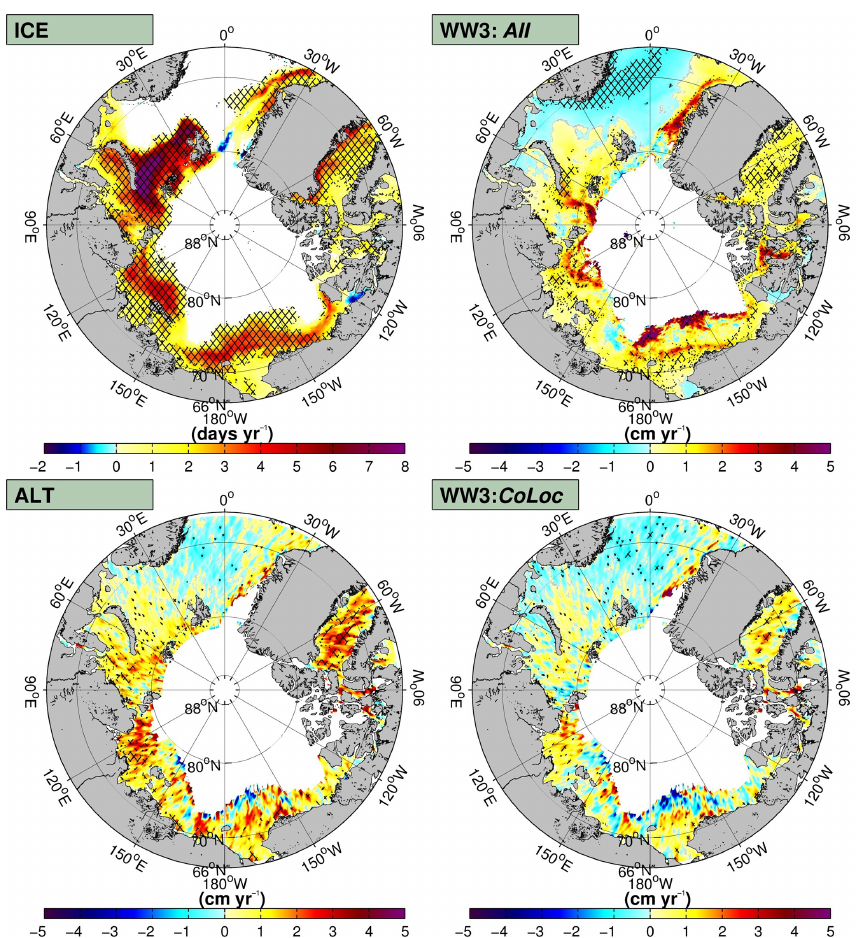
Figure 7. Ice coverage and H s trends given by Sen’s slope with the Mann–Kendall test (thatched areas). The top left panel displays the trend of the annual number of ice-free days per year (ICE). The other panels show the trends of monthly averaged H s data sets: using the entire 3h hindcast (top right: All), altimeters (bottom left: ALT), and co-located hindcast (bottom right: CoLoc) given in cmyear − 1